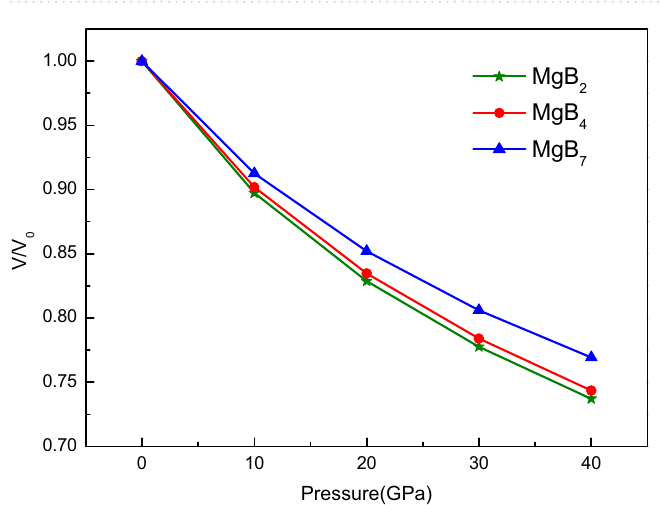
Figure 2. Variation between energy and volume of Mg–B compounds.